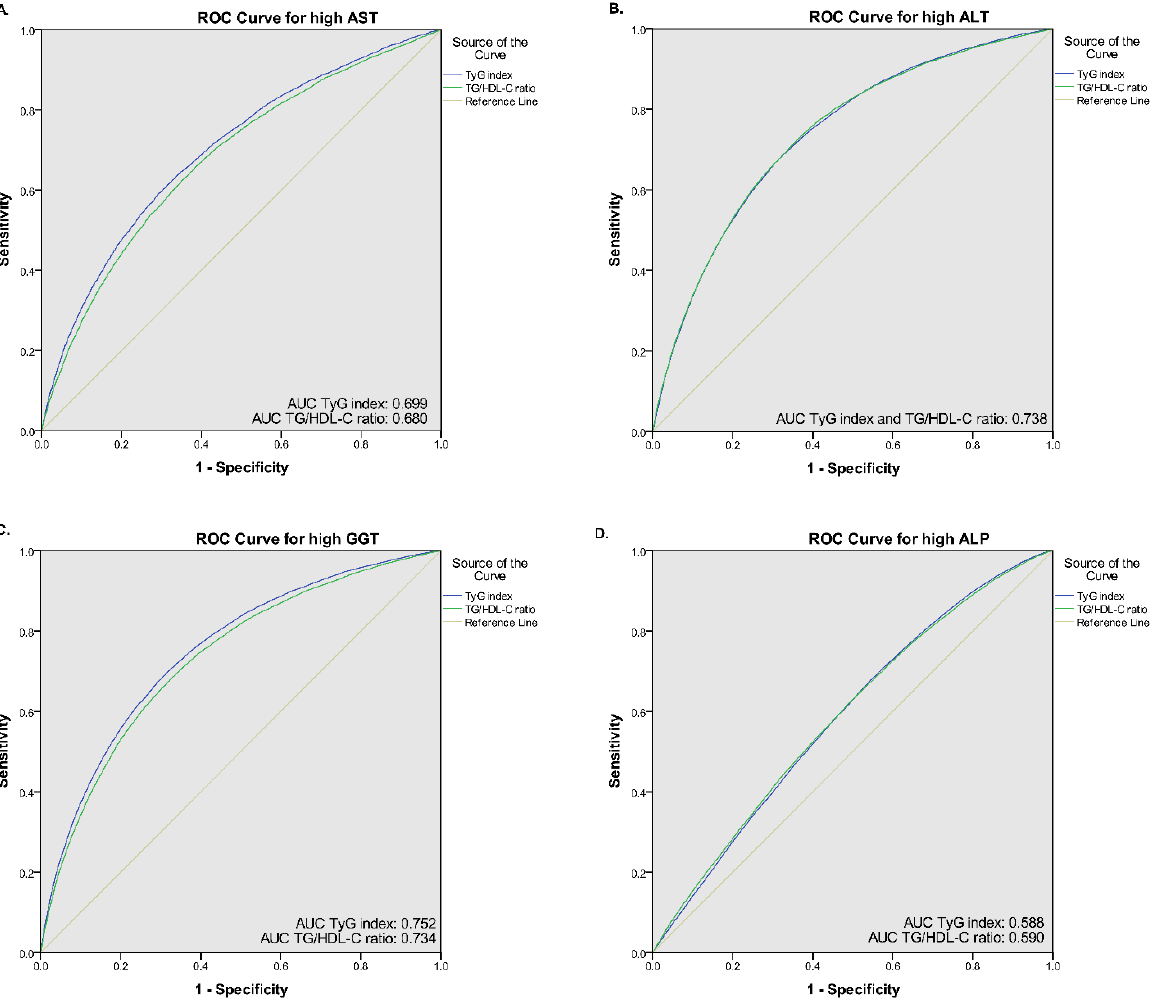
Figure 1. Receiver operative characteristic (ROC) curves of the TyG index and TG/HDL-C ratio for ( A ) high AST, ( B ) high ALT, ( C ) high GGT, and ( D ) high ALP.